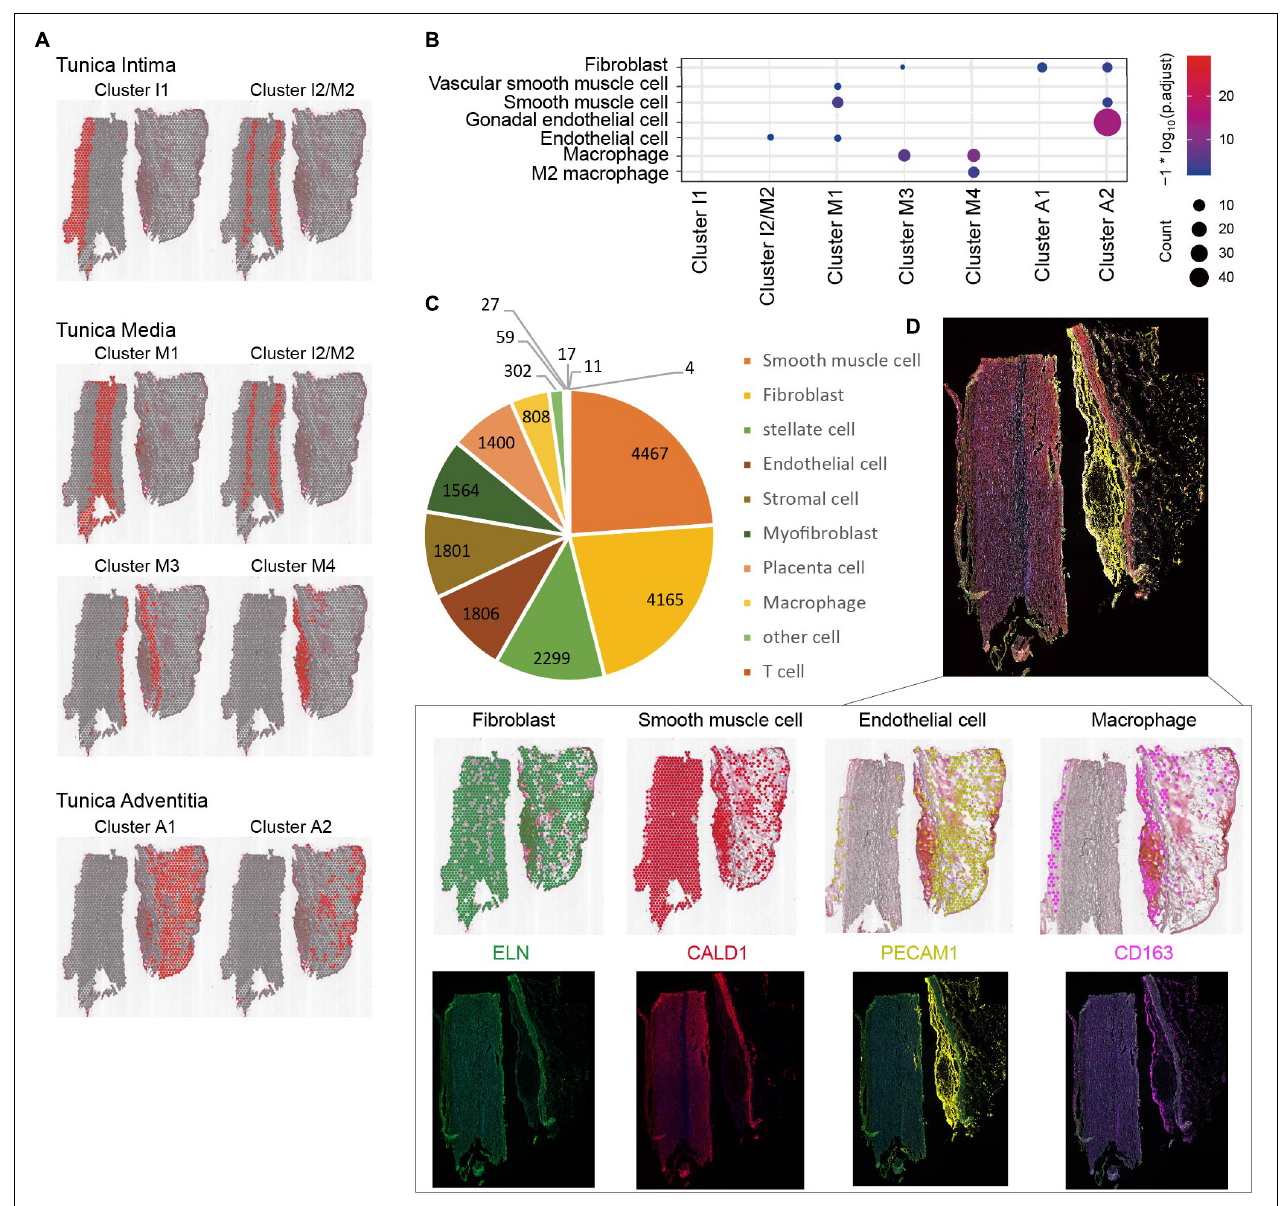
FIGURE 4 | Cell types identification of aortic dissection tissue. (A) The spatial location distribution of cell types in each cluster. Red region represents each cluster. (B) Major cell types by CellMarker database. (C) The major cell types and its number calculated by HCL database. (D) Verify the accuracy of cell types by multi-color